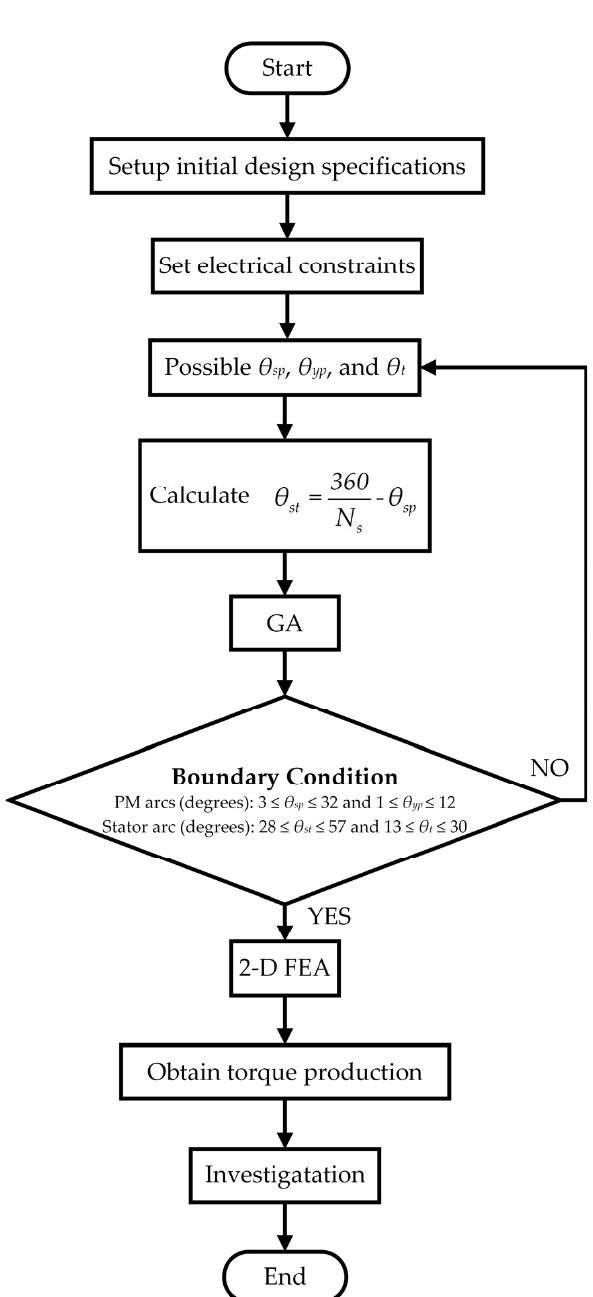
Figure 2. The flowchart of the optimization procedure.